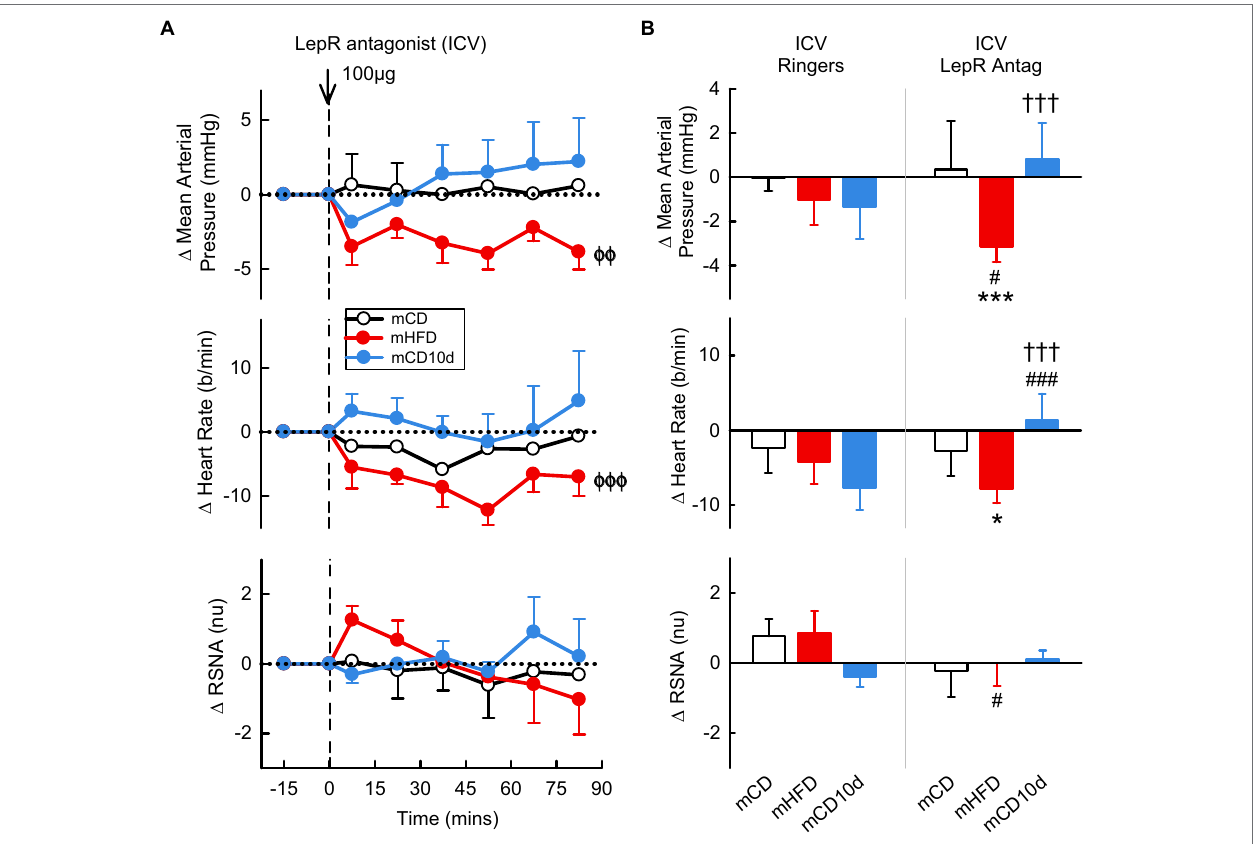
FIGURE 4 | Effects of leptin-receptor (LepR) antagonist injected ICV. (A) Average changes in mean arterial pressure (MAP), heart rate, and RSNA (normalized units) from control in each group after ICV injection of LepR antagonist (100 μ g, shown at dashed line) in maternal control diet (mCD; white, n = 7), maternal high fat diet (mHFD; red, n = 9), and mCD with 10d HFD (mCD10d; blue, n = 5) rabbits. Data are mean difference ± SED. ϕϕ p < 0.01, ϕϕϕ p < 0.001 for average effect of LepR antagonist. (B) Changes from control after both vehicle Ringer’s injection and LepR antagonist injection, averaged over all data points given ICV in mCD, mHFD, and mCD10d rabbits. Data are mean difference ± SED from the control period of each treatment group. * p < 0.05 and *** p < 0.001 for comparison to mCD; ††† p < 0.001 for mHFD vs. mCD10d; and # p < 0.05 and ### p < 0.001 for effect of LepR antagonist vs.